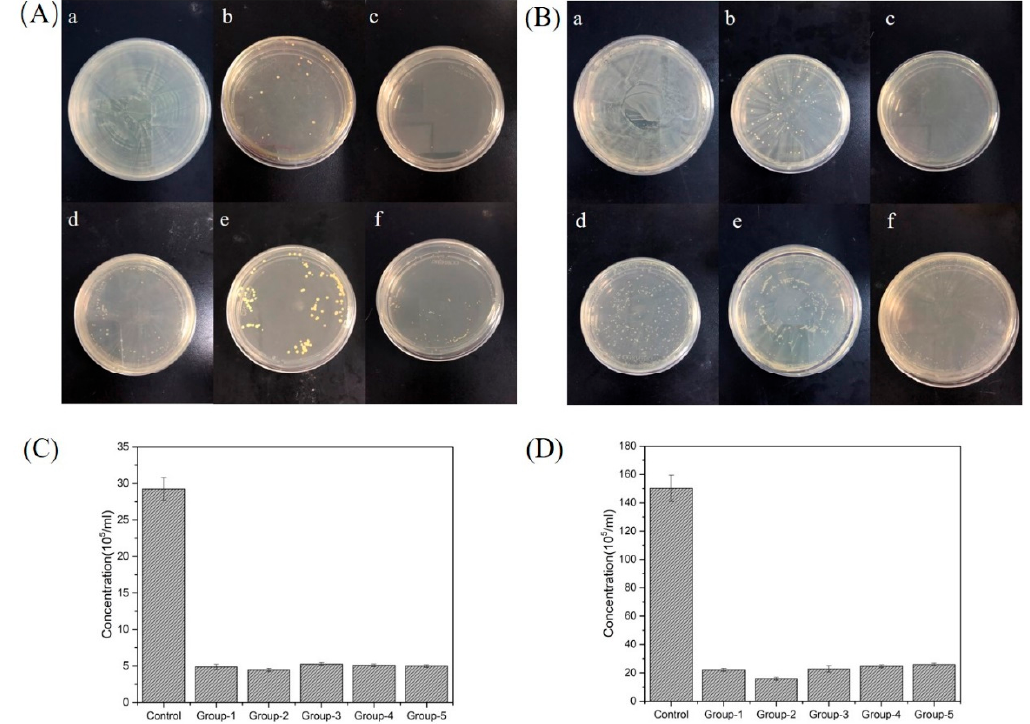
Figure 5. Antibacterial activity of different PMMA composite resins containing TiO 2 or/and PEEK. Agar plates displaying the samples with: ( A ) Staphyloccocus aureus ; ( B ) Escherichia coli . The change of bacterial concentration by co-culturing the samples with: ( C ) Staphyloccocus aureus ; ( D ) Escherichia coli .